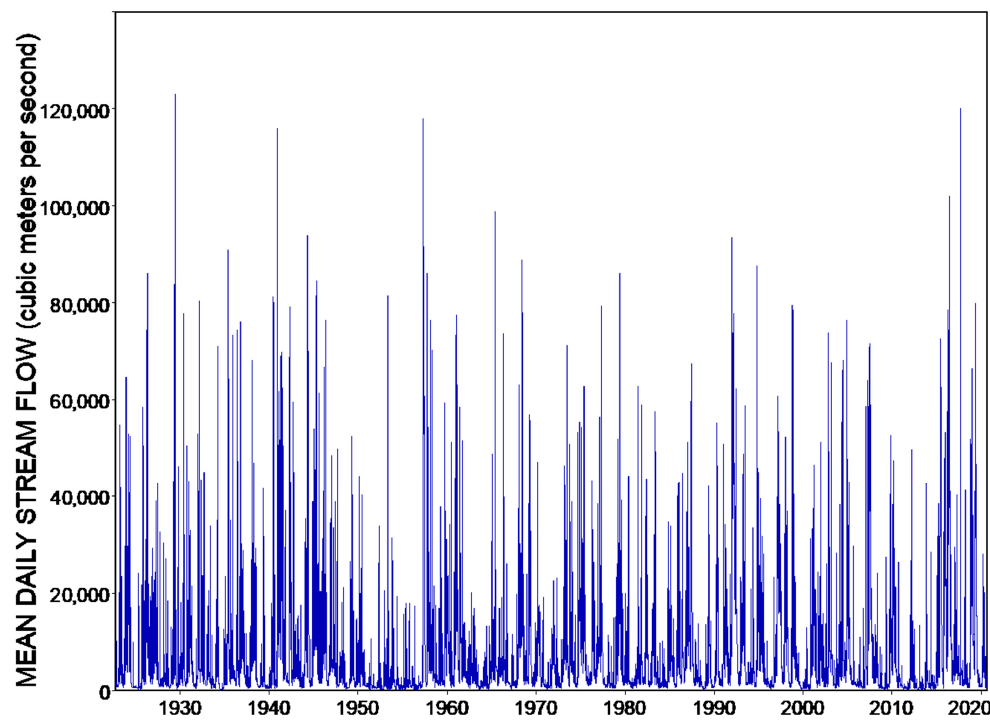
Figure 4. October 1922 through July 2020 daily flow of Brazos River at Richmond gauge.